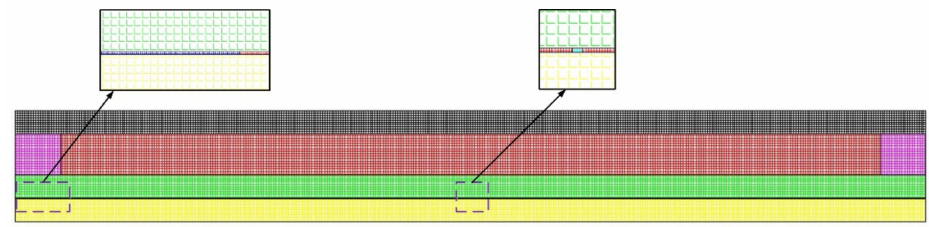
Figure 4. Finite element model of composite vacuum